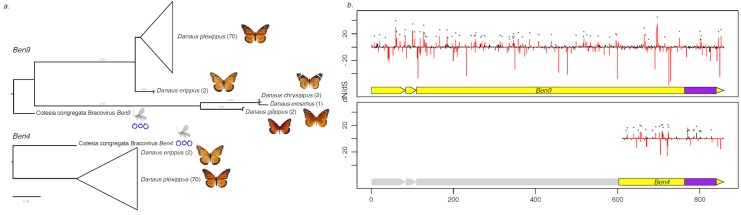
Measure of selection operating on Ben4 and Ben9 genes in D. plexippus and 4 related species.a) Phylogenetic tree based on the nucleotide sequence alignment of the region shared between Ben4 and Ben9 in Danaus species samples and CcBV. The values in brackets indicate the number of lepidopteran individuals used in the analysis. b) Plot of the dN/dS value of each codon along the Ben genes based on the alignment of the butterfly sequences. The red bars represent values that are significantly under positive or negative selection (HyPhy, p-value ≤ 0.1). The asterisks identify the sites also under positive selection with the PAML approach. The yellow blocks under the dN/dS graphs represent the Ben gene structure composed of three exons. The first exon corresponds to a PHA02737 domain and the BEN domain (represented in purple) is encoded by the end of the third exon. Note that the truncated Ben4 gene conserved in D. plexippus corresponds to the third exon of CcBV Ben4 gene, which contains the BEN domain.